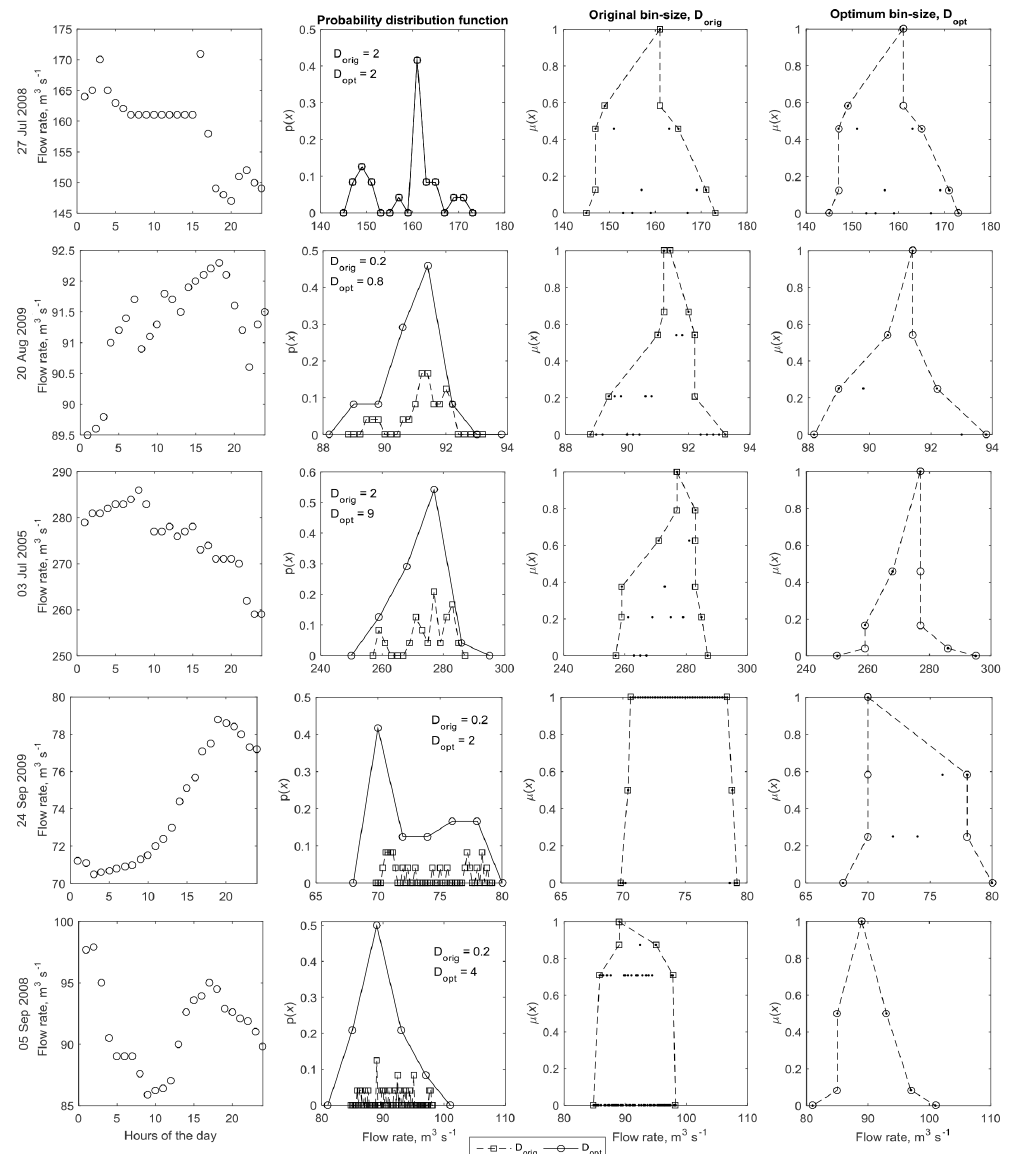
Figure 3. Sample results of probability–possibility transformation for flow rate, Q